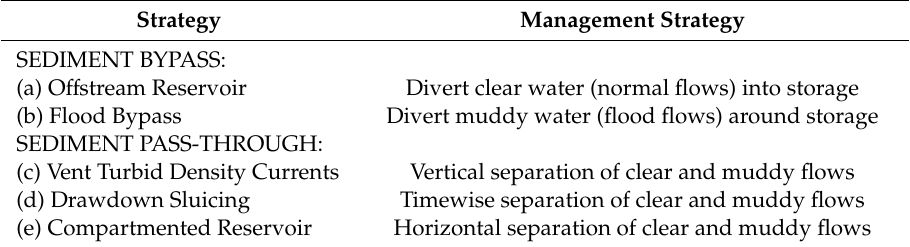
Table 1. Sediment Routing Strategies to Separate Flows of Clear and Muddy